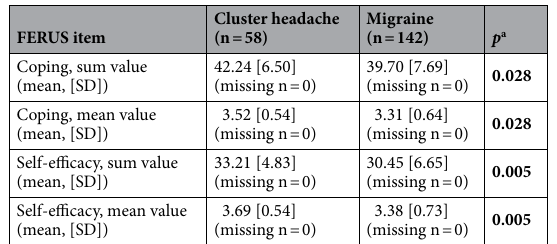
Table 8. FERUS results for both headache types. a Welch test. Significant values are in bold.